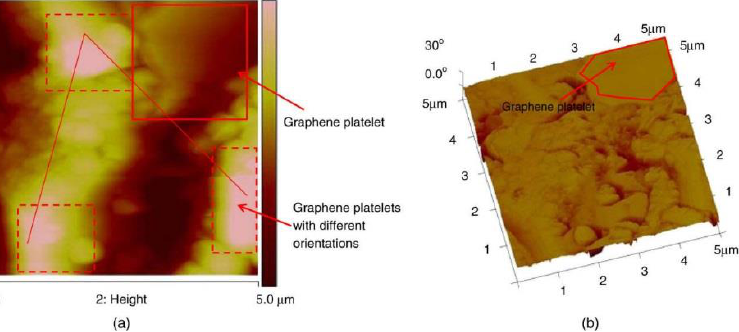
Figure 20. FFM images of GNP/cement composites: ( a ) Height image; ( b ) Phase image. Reprinted with permission from Ref. [108]. Copyright 2013 American Society of Civil Engineers.